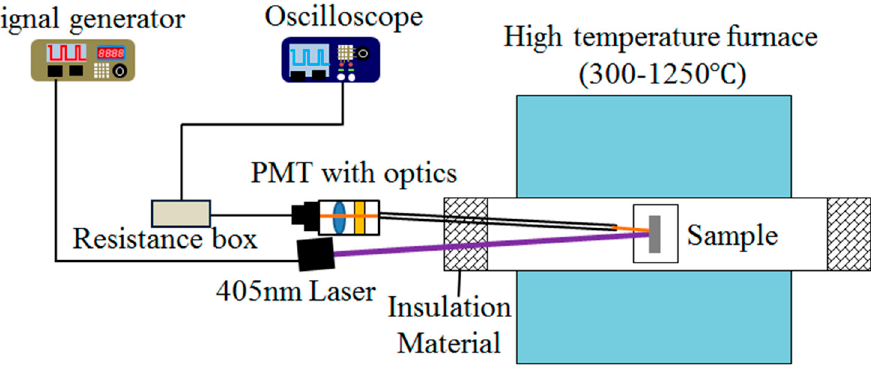
Figure 4. Schematic of TBC temperature sensing system.